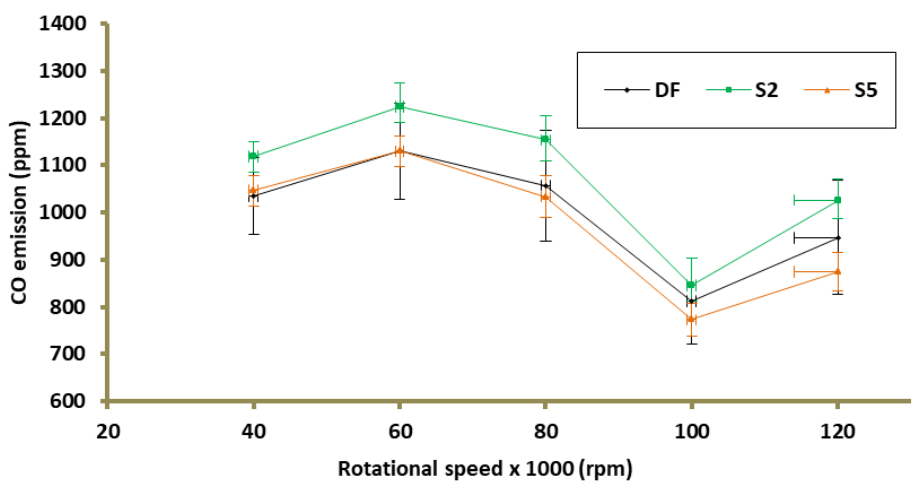
Figure 8. CO emission depending on the rotational speed.